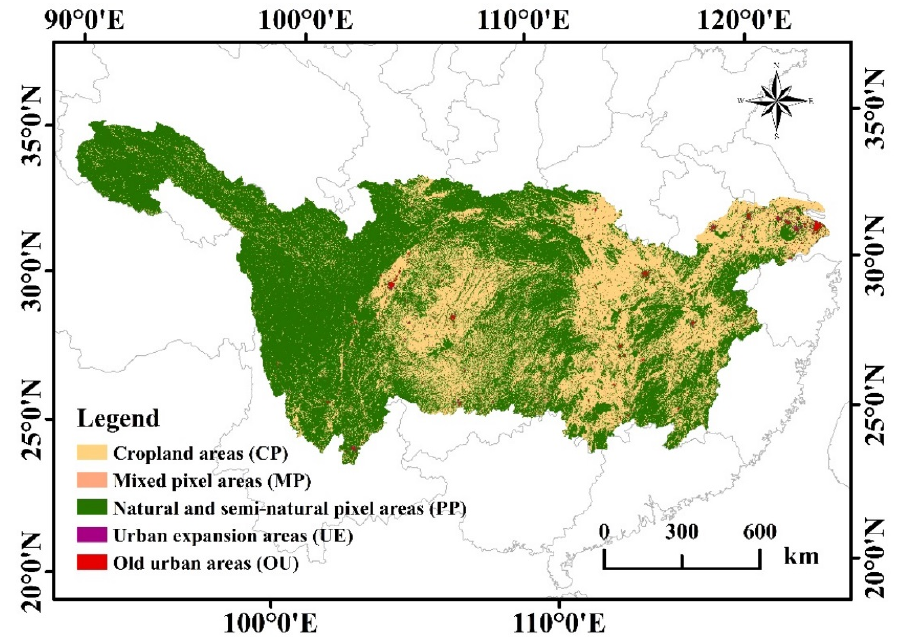
Figure 2. Spatial distribution of land use types in the Yangtze River basin in 2020. Table 2. Statistics on the proportion of land type